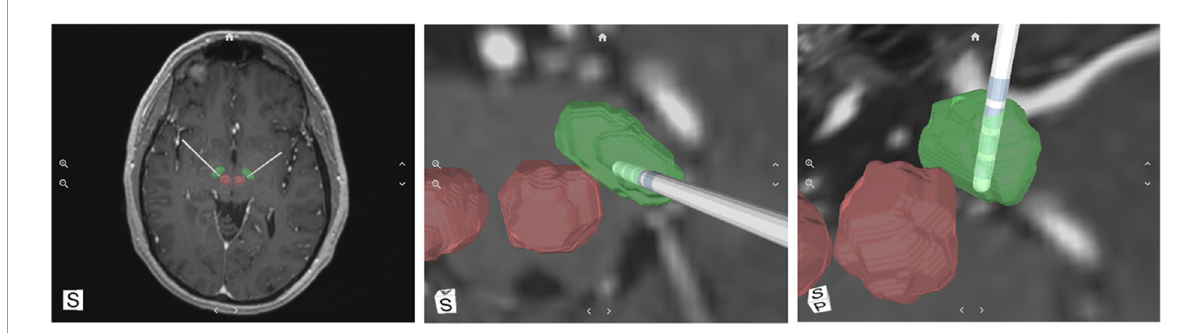
FIGURE1 A representative example of the SIS System output; a 3D reconstruction of subthalamic nucleus (STN) (green), red nuclei (red) and the deep brain stimulation (DBS) electrode with its corresponding individual contacts.